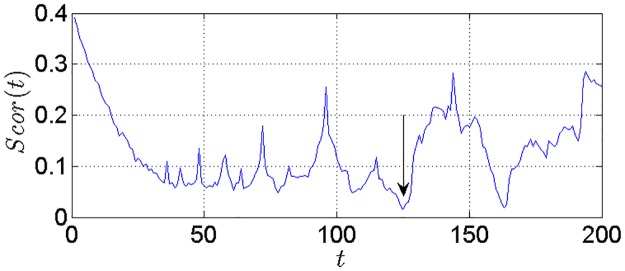
The Scor(t) ~ t curve.